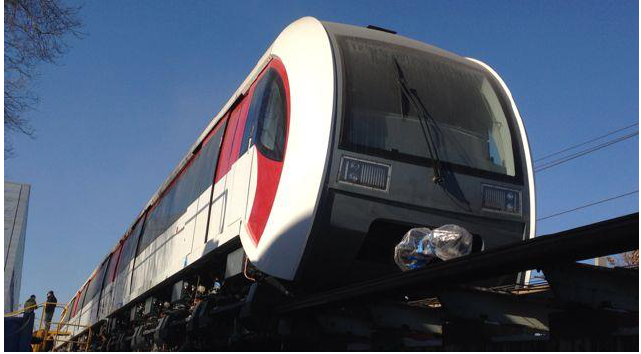
Figure 12. Field experiments on a full-scale maglev train at Tangshan maglev engineering experiment base.